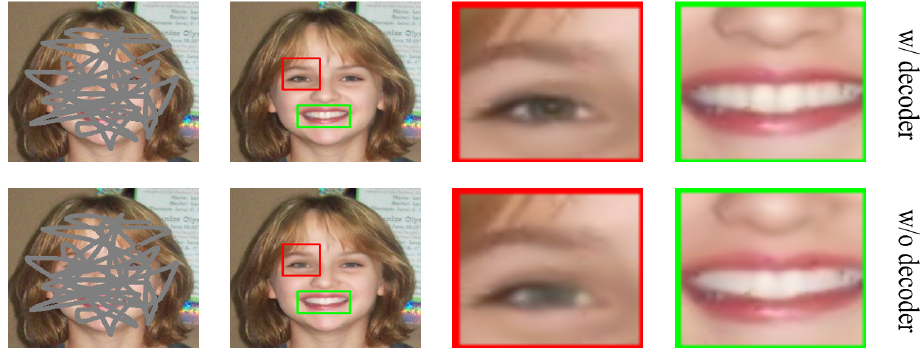
Figure 8. The effect of the decoder on the completion result.